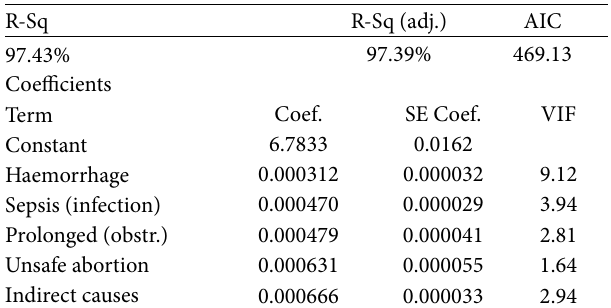
The 𝑟 value in Table 2 represents the correlation between the variables and the 𝑝 -value represents the two tailed 𝑝 -value for the test of associations between the two variables. Correlation is significant at 0.01 (2-tailed). Correlation is significant at the 0.05 level (2-tailed). ∗∗∗ Table 3: Summary of the Poisson model based on the major signif- icant causes. 푅 2 = 97.43 % .